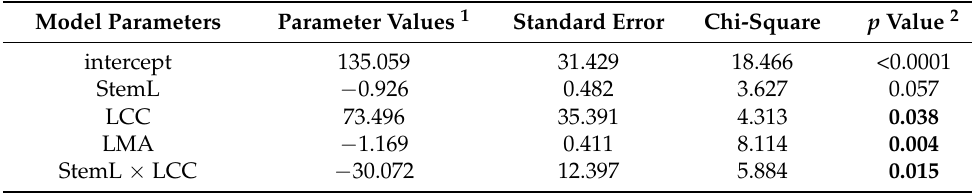
Table 3. Multiple linear regression analysis to predict yield (g/m 2 ) using several functional traits stem length (StemL), leaf mass area (LMA), and leaf chlorophyll concentration (LCC) for the two studied fields combined. The best model, chosen after Lasso variable selection (least absolute shrinkage and selection operator) had an AICc of 382.1 and a coefficient of determination of R 2 = 0.345. None of the predictors were correlated ( p > 0.05), and the predictor distributions were not significantly different than a Normal distribution.